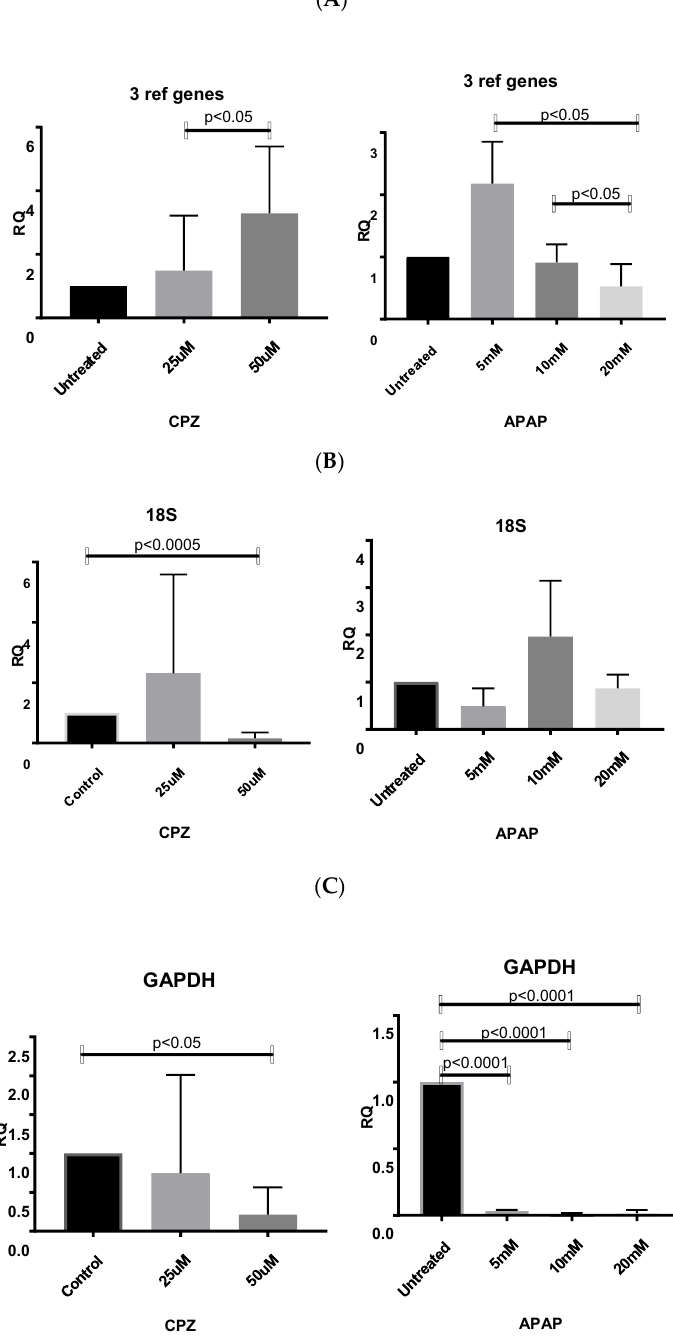
Figure 4. Fold change in mRNA expression (±SD) of liver abundantly expressed Albumin in HepaRG cells stimulated with different doses of CPZ or APAP when mRNA expression was normalized using: ( A ) the geometric mean of the validated reference genes (n = 5), ( B ) 18S (n = 6), and ( C ) GAPDH (n = 5). The fold change in mRNA expression is relative to HepaRG untreated cells.